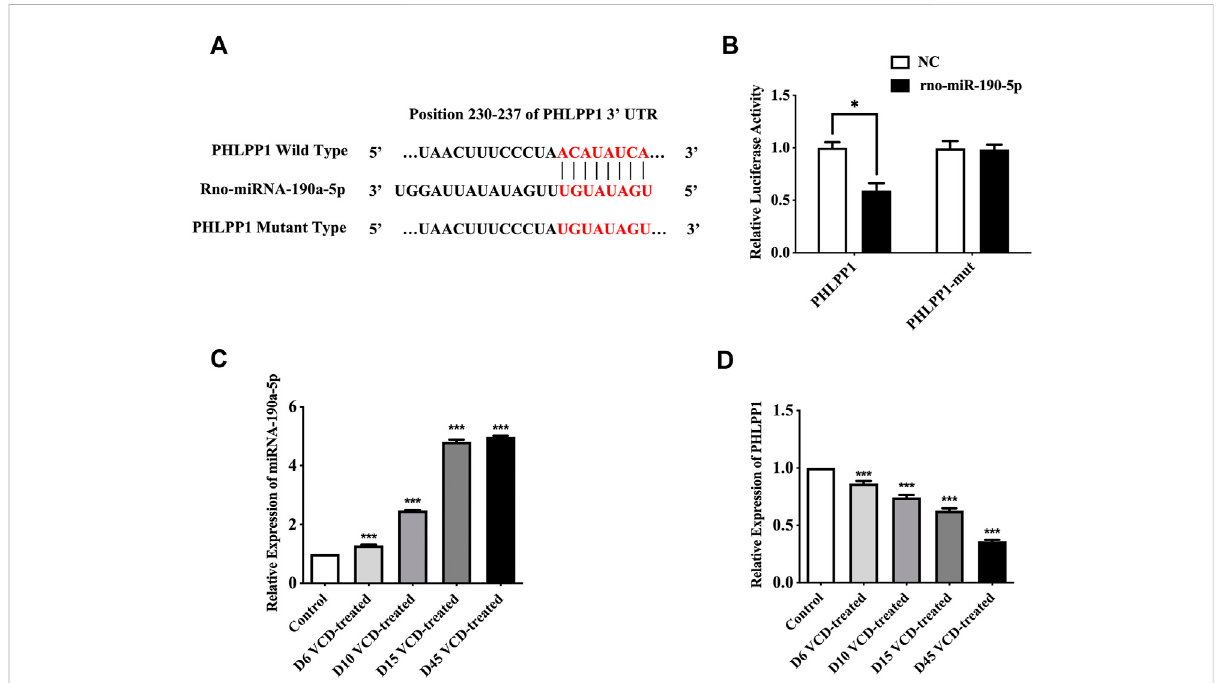
MiRNA-190-5p directly targets PHLPP1 during the VCD-treating process. (A) Diagram of putative miRNA-190a-5p binding sites of PHLPP1. Binding sequences for miRNA-190a-5p in the 3 ′ -UTR of PHLPP1 and the mutations in the 3 ′ -UTR of PHLPP1 are presented. (B) Luciferase activity of thewild-typePHLPP13 ′ -UTR (PHLPP1) andmutantPHLPP1 3 ′ -UTR(PHLPP1-mut)co-transfected withmiRNA-190a-5p mimics(rno-miR-190a-5p) or negative control (NC) was measured. (C) and (D) qRT-PCR analysis of miRNA-190a-5p, PHLPP1 mRNA in rat ovaries tissues during the VCD treatingprocess(D6,D10,D15,andD45).Dataaresummarizedandpresentedasmean±SEMfromthreeindependentexperiments.* p ＜ 0.05vs.NC and *** p ＜ 0.001 vs.